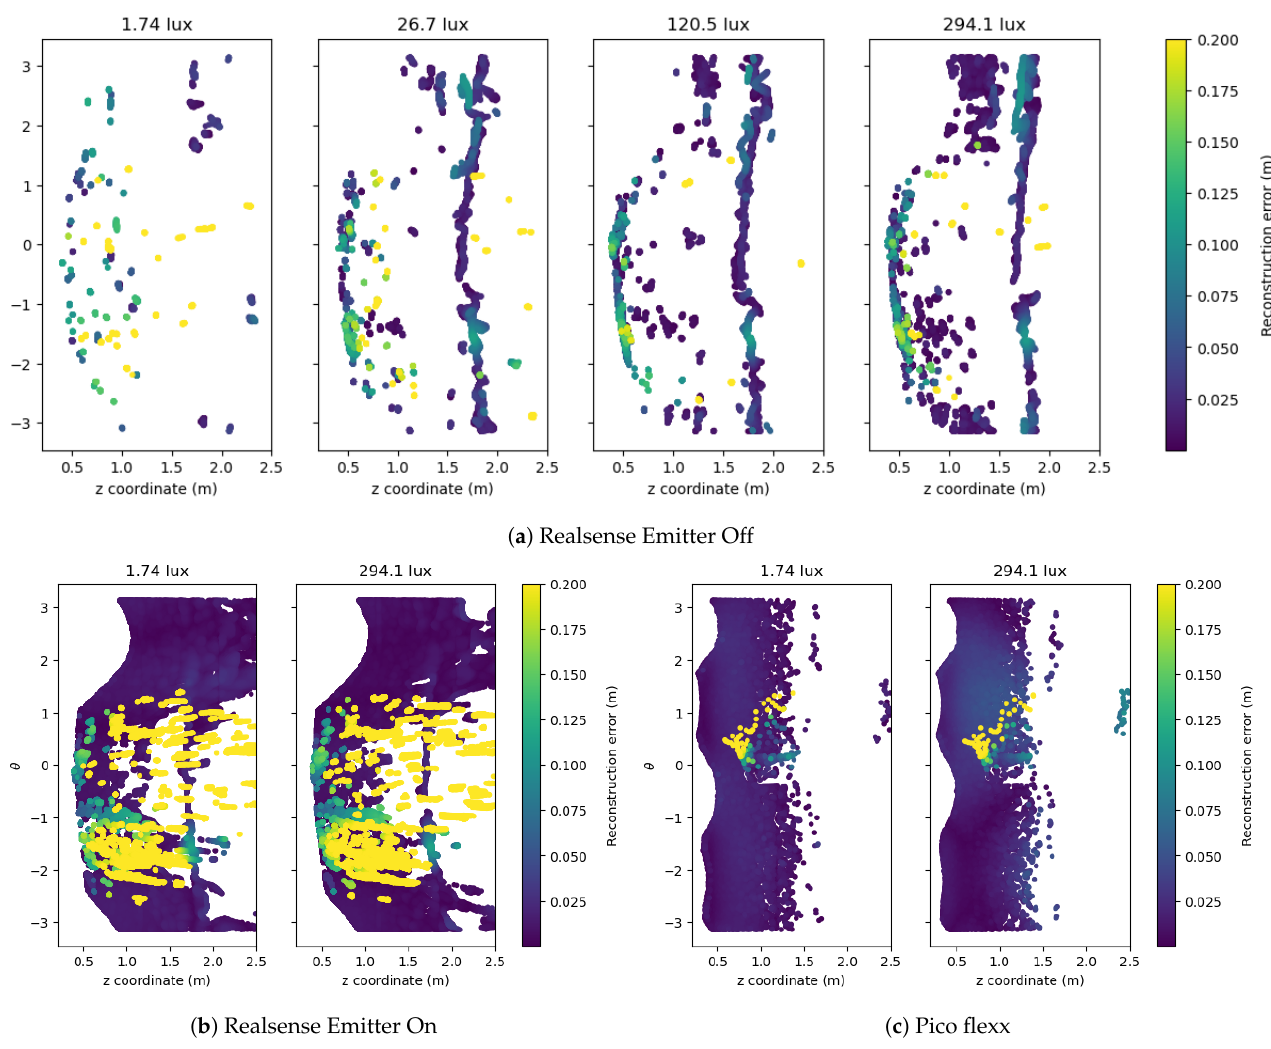
Figure 13. 2D projection of the cloud-to-mesh distance from the three sensor configurations in the laboratory setup. The color coding of the cloud represents the cloud-to-mesh distance. If points overlay each other on the 2D projection, the point with the largest cloud-to-mesh distance is plotted on top and is thus fully